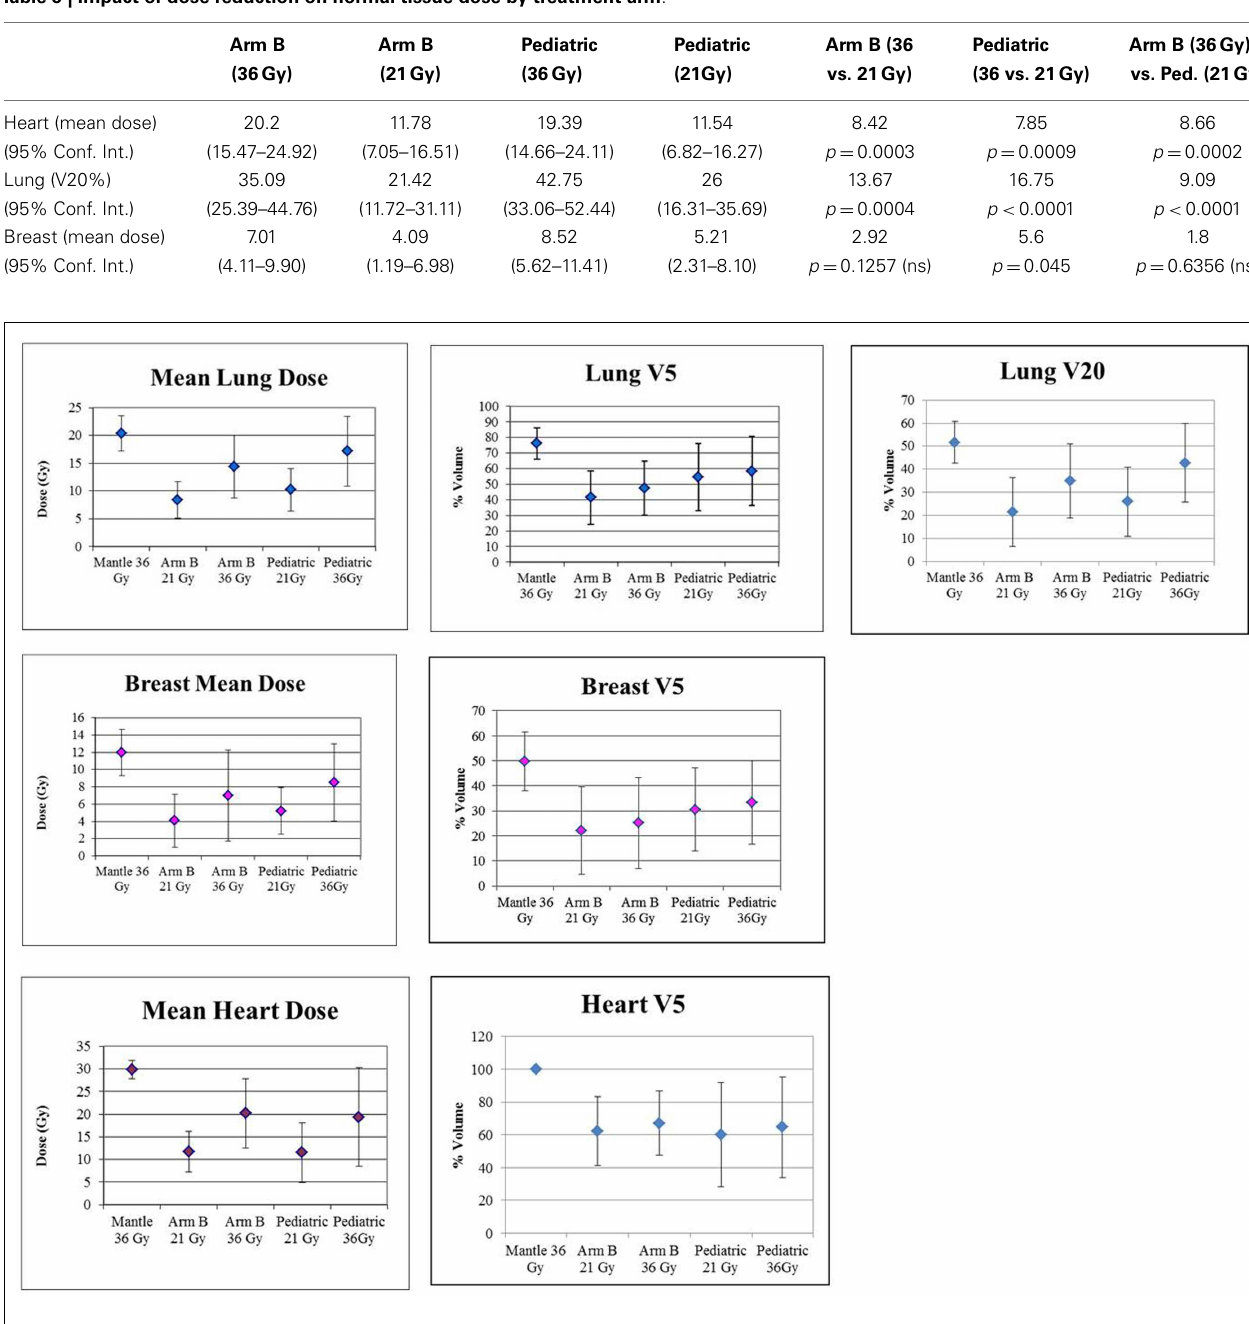
FIGURE 4 | Graphic presentation of lung, breast and heart mean dose andV5, and LungV20. Error bars represent ± SD